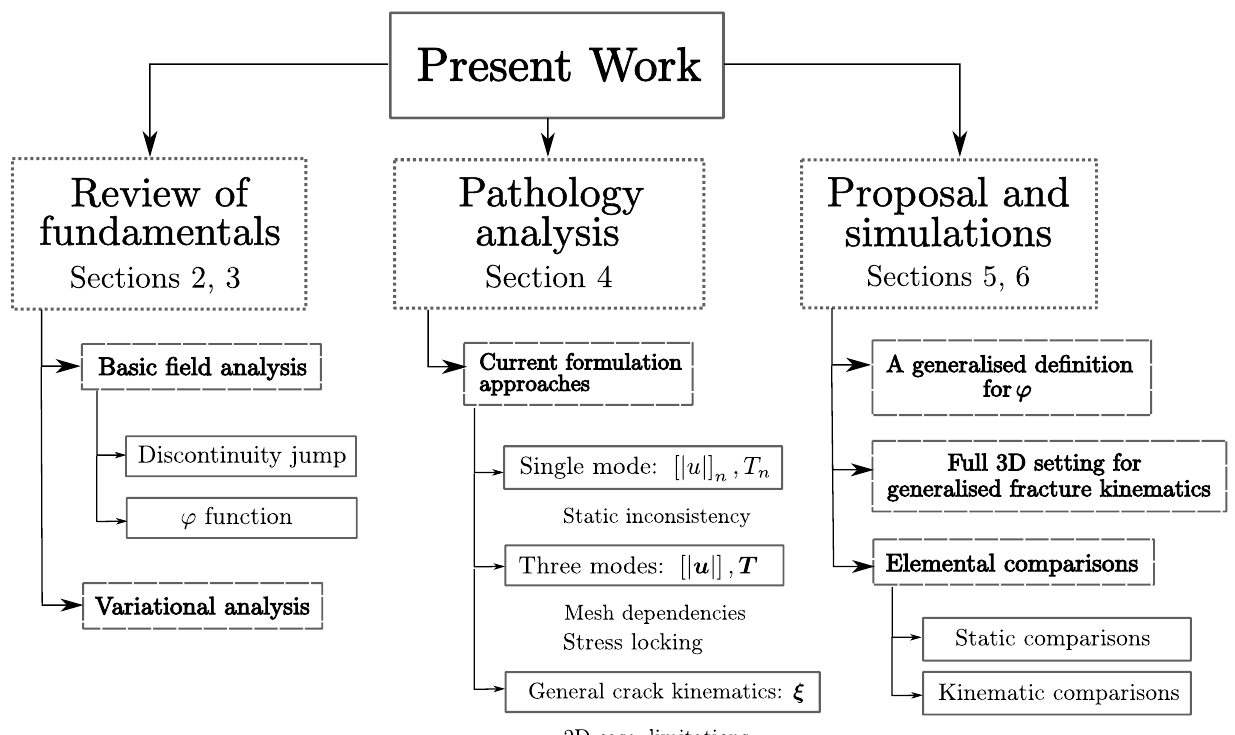
Figure 1. Auxiliary schema describing the general organisation of the theoretical works presented in this